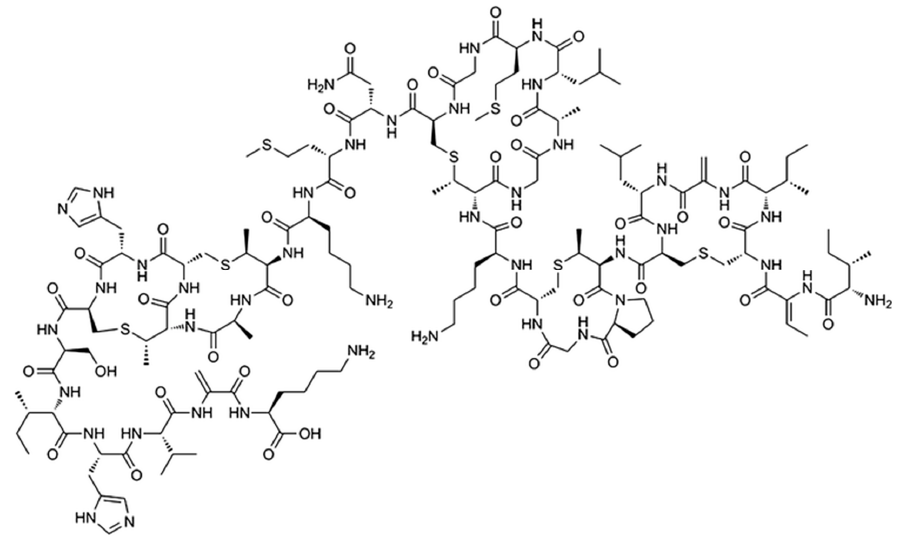
Figure 8. Chemical structure of Nisin. Reproduced with permission from Salmieri et al. [74]. Springer Nature copyright © 2014.